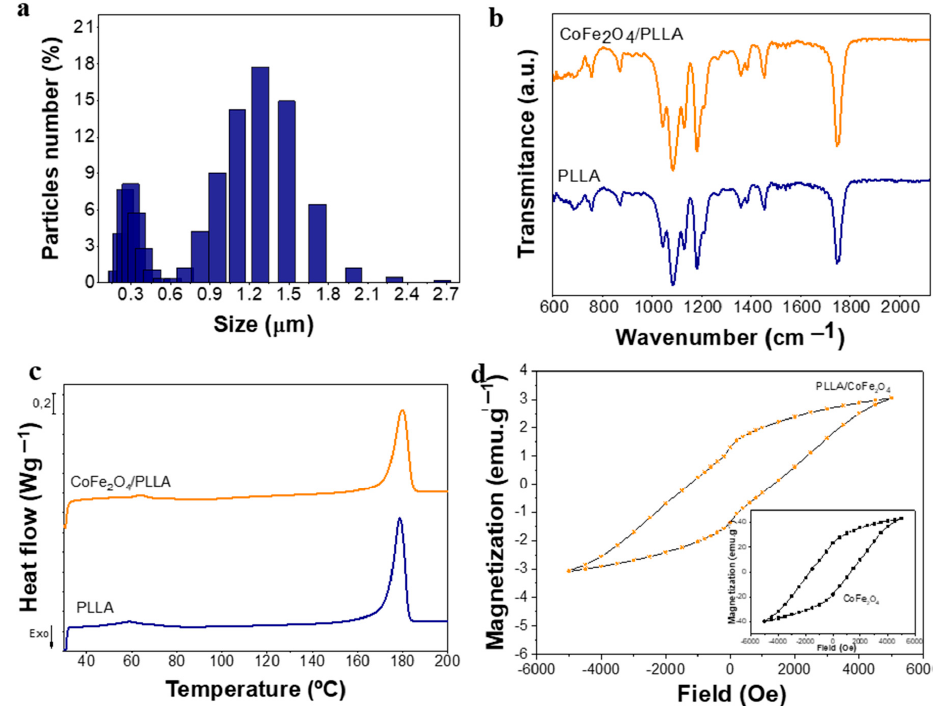
Figure 3. Microspheres characterization: ( a ) hydrodynamic size distribution of neat microspheres obtained by dynamic light scattering (DLS) measurements; ( b ) FTIR-ATR spectra and ( c ) differential scanning calorimetry (DSC) curves of both synthesized microspheres; and ( d ) magnetization curves of magnetic microspheres and CoFe 2 O 4 pure powder (inset) obtained by vibrating sample magnetometer (VSM) experiments.